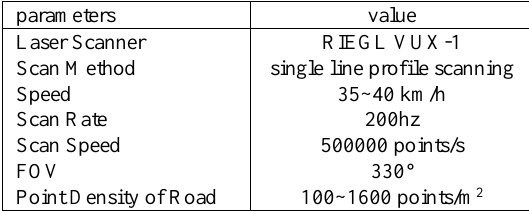
Table 7. Point cloud collection